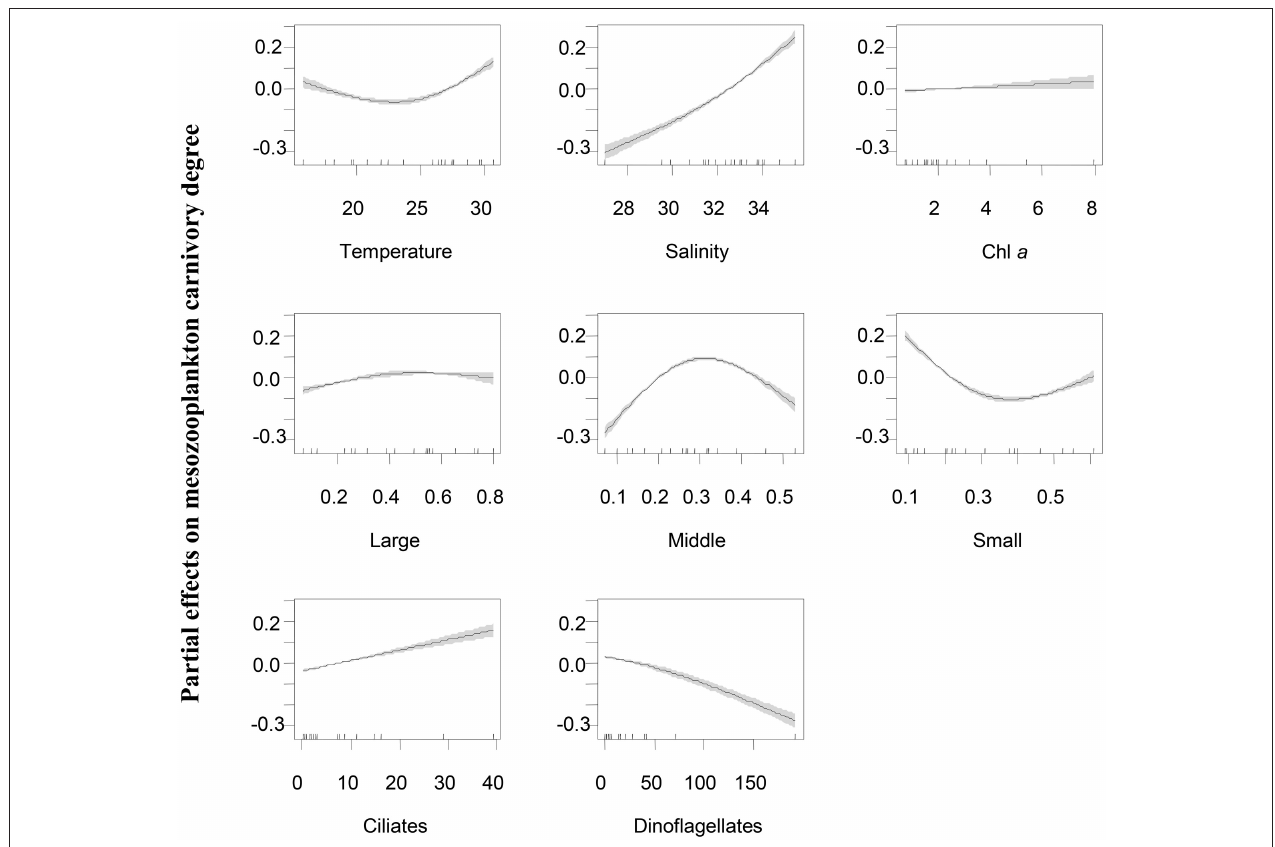
FIGURE 5 | Partial effects of variable predictors on mesozooplankton carnivory rate at station EO. Predictors includes temperature, salinity, Chl a concentrations, percentages of large-sized (Large), middle-sized (Middle) and small-sized phytoplankton (Small) in total phytoplankton community, ciliate biomass, and dinoflagellate biomass. Shades indicate 95% of confidence